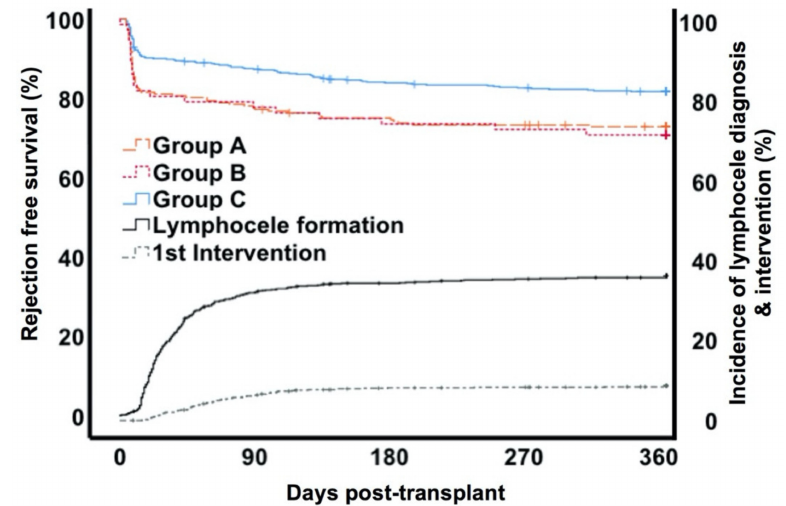
Figure 1. Timing of rejection episodes, first diagnosis of lymphocele formation and first intervention of lymphoceles. * Group A = lymphocele conservatively monitored; Group B = lymphocele with intervention; Group C = control.